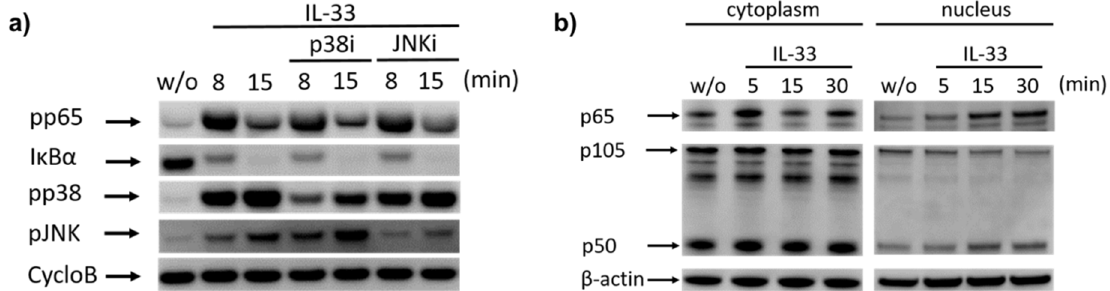
Figure 3. IL-33-mediated activation of NF- κ B is independent of p38/JNK and comprises the nuclear translocation of p65. ( a ) To investigate the impact of p38 and JNK on IL-33-induced signaling events, MCs were pre-treated for 15 min with the according inhibitors (or no inhibitor as control) prior to stimulation with IL-33 for 8 and 15 min. Note that neither the p38i nor the JNKi affected pp65 and I κ B α , while both inhibitors affected the phosphorylation of their own targets. ( b ) Nuclear and cytoplasmic fractions of IL-33-stimulated MCs were prepared to visualize NF- κ B translocation by immunoblot. Representative immunoblots out of two independent experiments each are shown in a and b. CycloB = cyclophilin B (loading control), p38i = p38 inhibitor (SB203580), JNKi = JNK inhibitor (SP600125), w/o = without IL-33 (negative control).